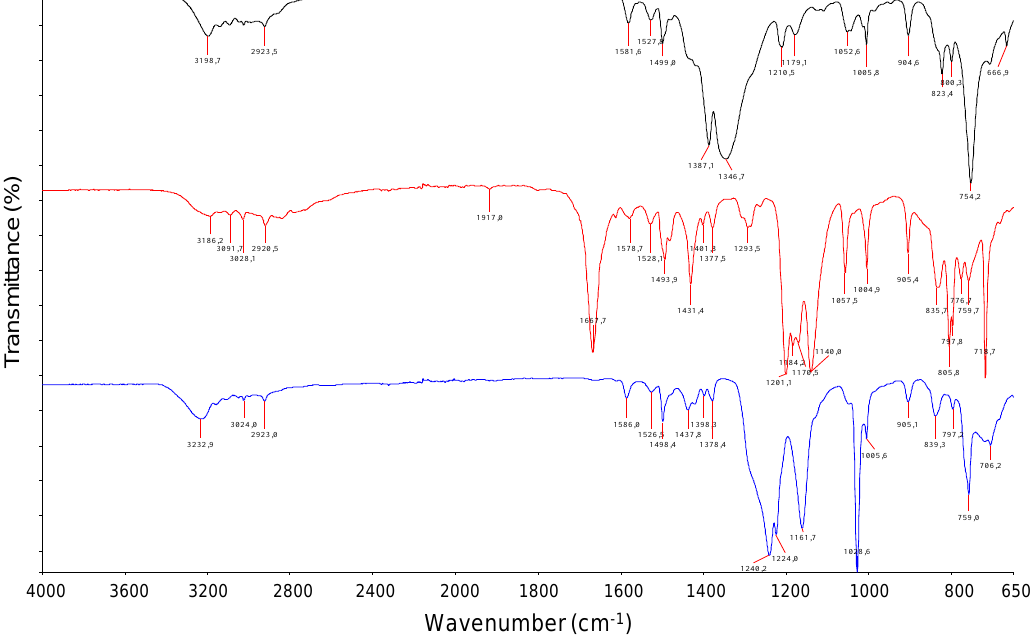
Figure 2 . FTIR spectra of silver(I) CPs 1 (black), 2 (red), and 3 (blue). Figure 2. FTIR spectra of silver(I) CPs 1 (black), 2 (red), and 3